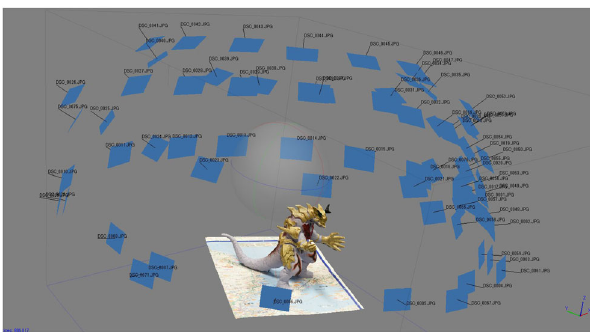
Fig. 1 Geometry reconstruction result using commercial software PhotoScan . Each blue square represents the estimated viewpoint of the input images.